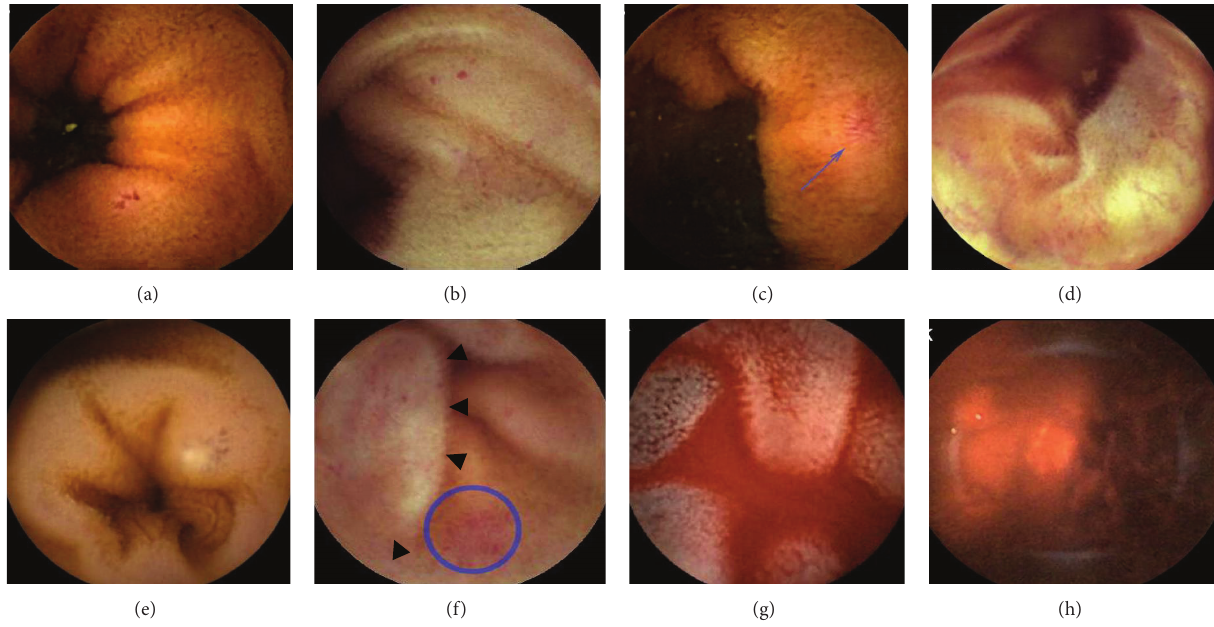
Figure 3: Portal hypertensive enteropathy (vascular lesions, grade 2) found by capsule endoscopy. (a) Red spots, (b) red spots with mucosal granularity, (c) angioectasia (blue arrow), (d) varix with bluish coloration, (e) small saccular varix with a bluish color change and shinning surface, (f) saccular-shaped varix (black arrow head) with shiny and bluish coloration, and hyperemia (blue circle), (g) varix with bluish coloration and fresh blood in the small bowel, and (h) active bleeding due to small bowel